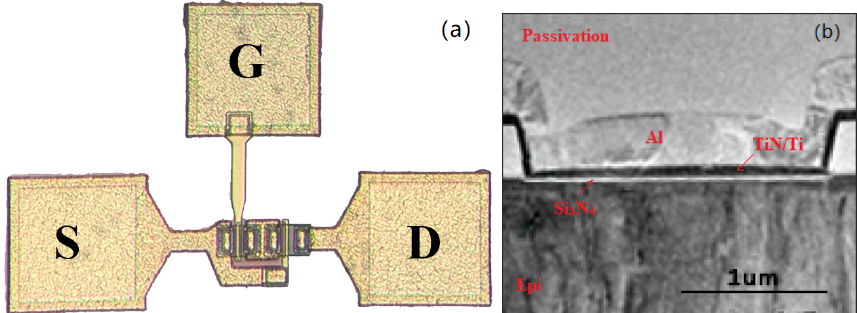
Figure 2. ( a ) Schematic view and ( b ) Cross-section TEM image of the fabricated all-GaN integrated MIS-HEMT.